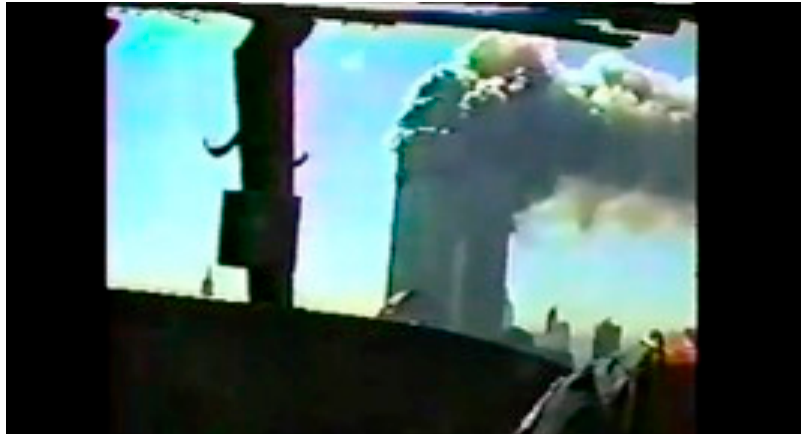
Figure 4. Frame from an amateur video filmed from within a police helicopter flying near the World Trade Center of Manhattan during the 11 September terrorist attacks. (Available at: https://www.youtube.com/watch?v=GDlZ2CdQgXE, last accessed: 21 August